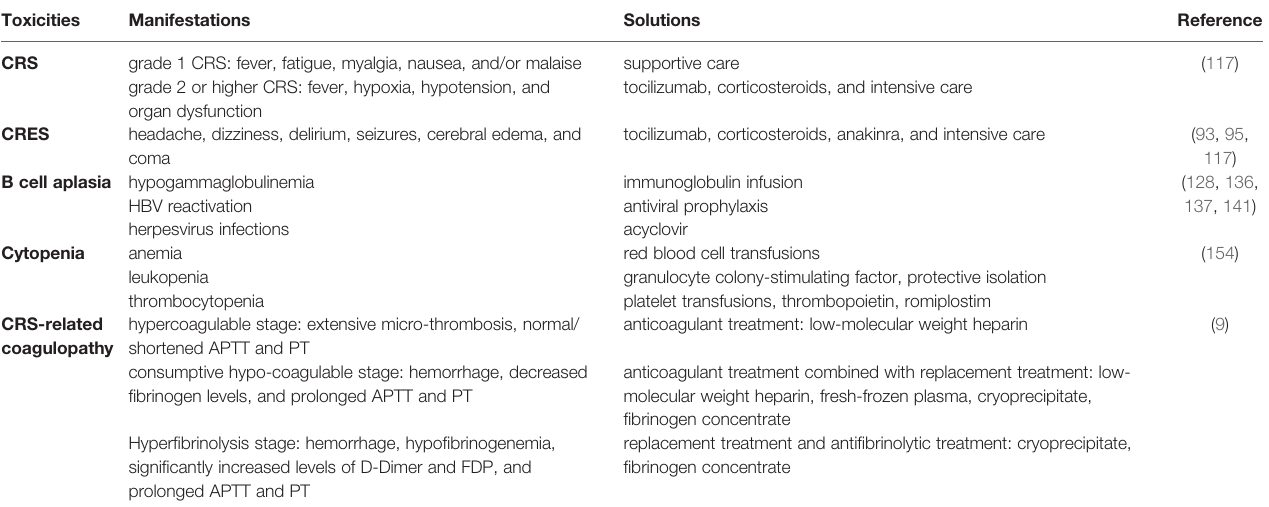
TABLE 2 | Toxicities related to CAR-T cell therapy and effective